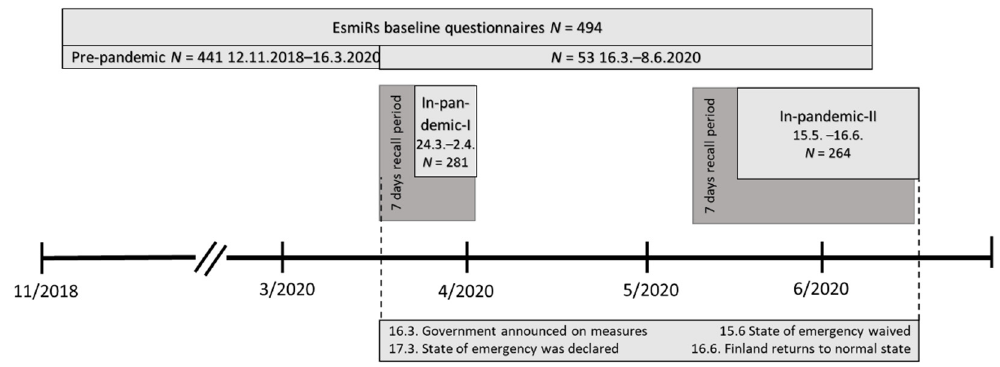
Figure 1. Timelines for the EsmiRs baseline and COVID-19 questionnaires. Dates are day.month.year.